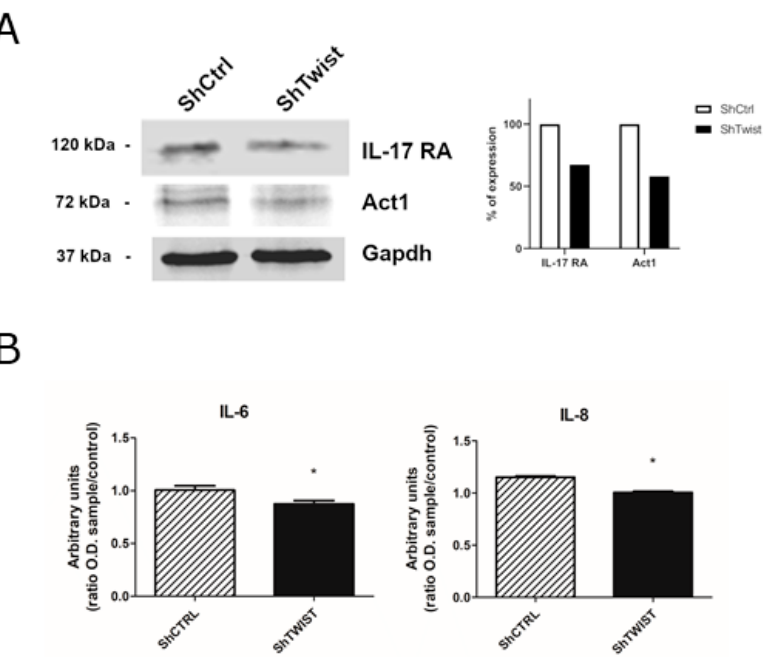
Figure 6. Evaluation of IL-17 signaling in TWIST1-knockdown BC cells compared to control cells. ( A ) Protein levels of Act1 and IL-17RA in ShCTRL and ShTWIST cells. GAPDH was used to ensure that the same sample amounts were loaded for immunoblotting. Densitometric analysis was done using ImageJ software. ( B ) Levels of secreted IL-6 and IL-8 proteins in the supernatant of ShCTRL and ShTWIST cells. Data are shown as the mean ( ± SD). * p < 0.05.